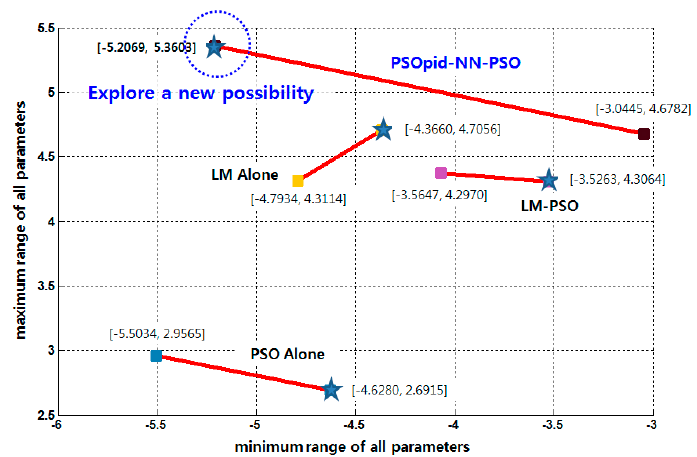
Figure 6. Exploration of a new possibility. Each (x,y) coordinate indicates the minimum and maximum of all parameters such as weights and biases, and the outcomes are from each independent trial.